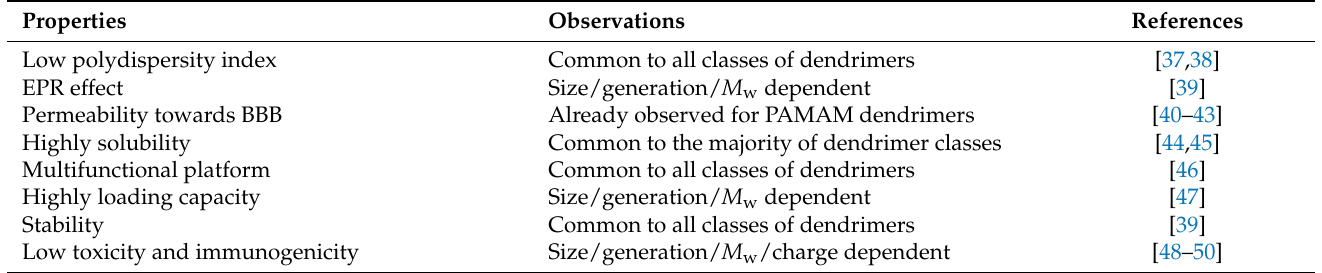
Table 2. Suitable properties of dendrimers to be used as delivery systems in different